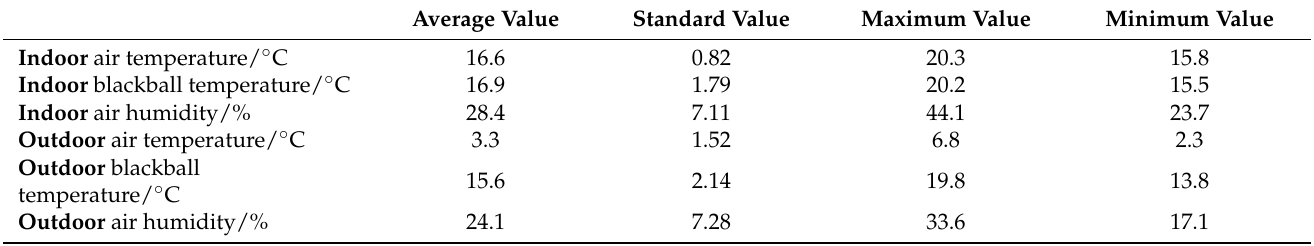
Table 3. Indoor and outdoor thermal environment parameters.